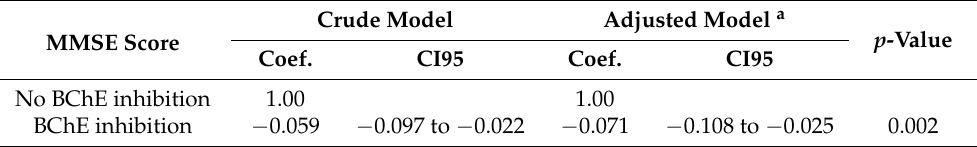
Table 3. Association between BChE inhibition and MMSE score in multivariate analysis. MMSE